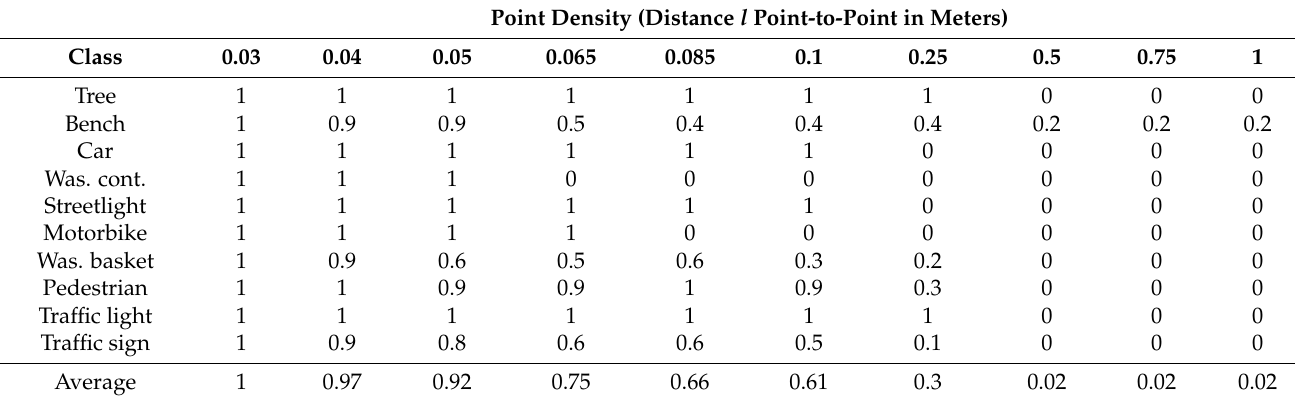
Table 3. Recall of the classification with point density